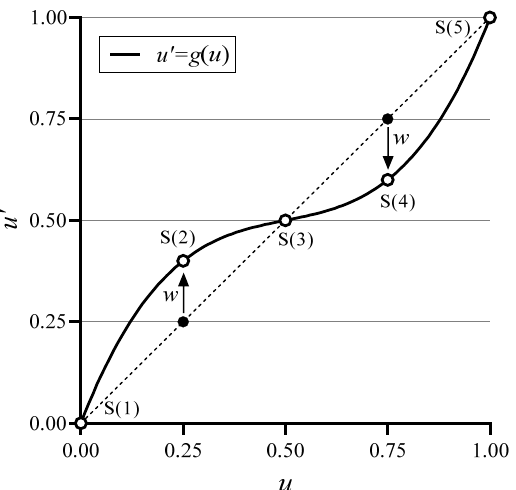
Figure 12. Adjustment function to modify the sampling position on the UV plane.